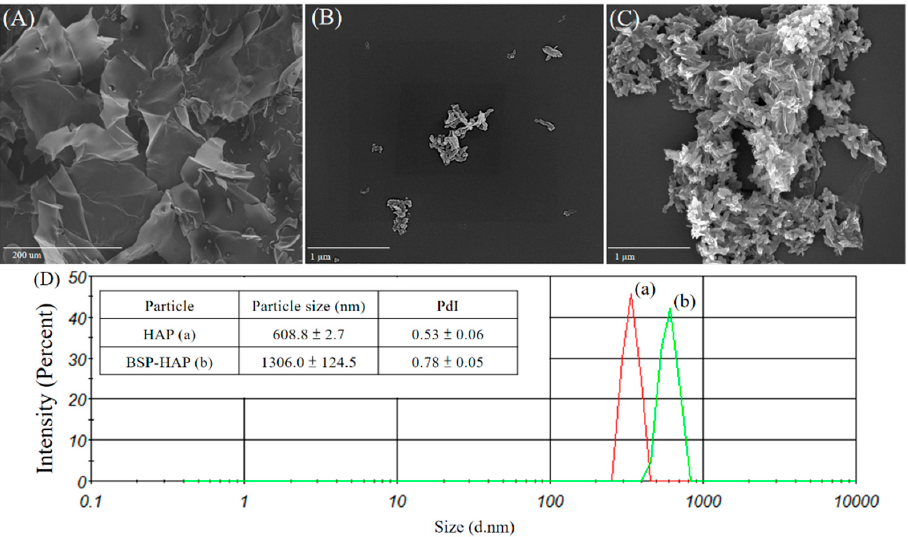
Figure 3. SEM images of ( A ) BSP, ( B ) HAP, and ( C ) BSP-HAP. The morphology of the extracted BSP showed a typical dried hydrogel morphology with many pores left from water-occupied space. The HAP showed a needle-like or flake morphology, and some grains would aggregate into a spherulite structure. The morphology of BSP-HAP was as the morphology of HAP spherulite aggregates and smoothly canopies gel-film on the crystal. The analysis of average particle size and distribution ( D ). The peak (a) was the particle size distribution of HAP; the peak (b) was the particle size distribution of BSP-HAP. The average particle size of HAP and BSP-HAP were in the range of 900 − 2000 nm. The summary is shown in the table on the left side.